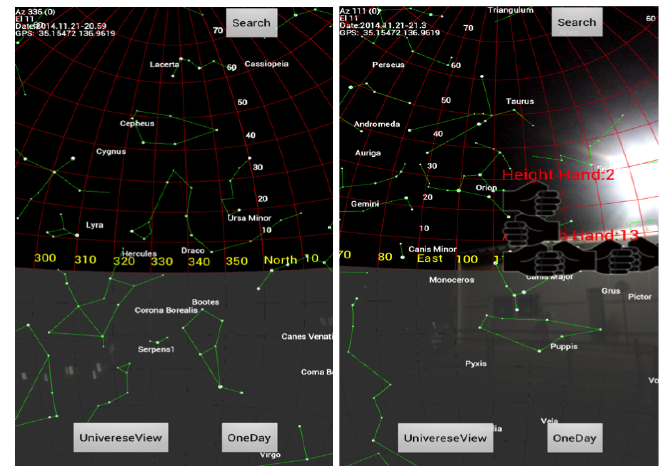
Figure 5. The AR view interface of R-WOSARLS ( left ), locating the constellation with hand images in AR view ( right